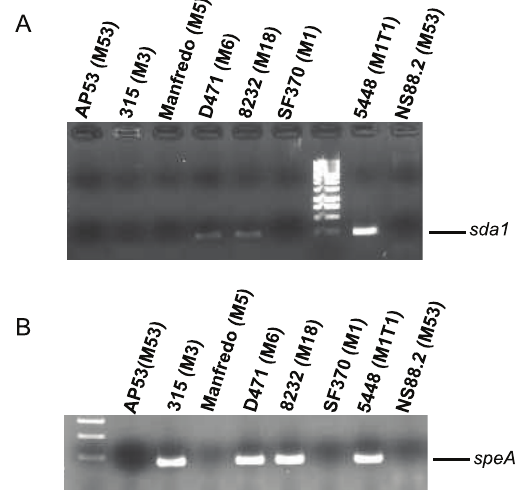
Figure 3. PCR of gDNA. Primers specific for the (A) sda1 gene and (B) speA gene were used for PCR analysis of genomic DNA. The GAS strains employed are indicated in the figure along with the emm serotype for each of these strains (in parenthesis). M refers to the molecular size marker.